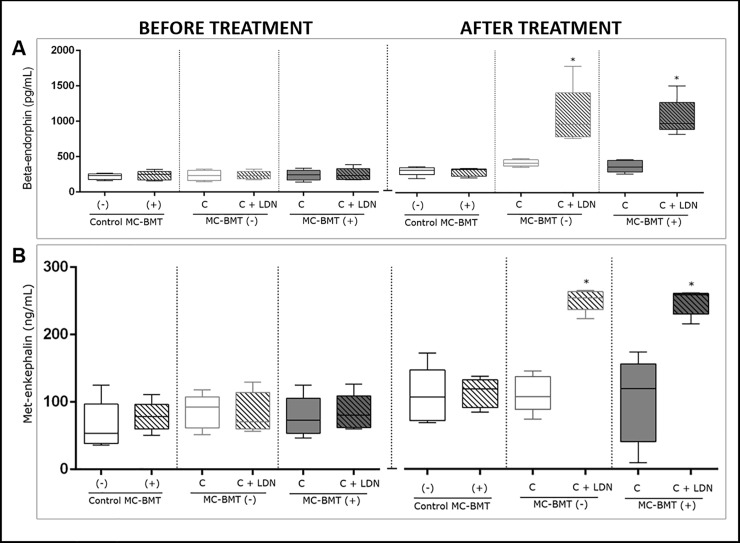
Beta-endorphin and met-enkephalin concentrations in the blood of female dogs with cancer as benign mixed tumors.The results are divided into before and after the proposed treatment and subcategorized by the absence (-) or presence (+) of metastasis. Beta-endorphin concentrations for each sample (in pg/mL) were determined by ELISA (A). Met-enkephalin concentrations for each sample were determined by ELISA and calculated in ng/mL (B). *Significant differences at p < 0.05, according to the Kruskal-Wallis statistical test.